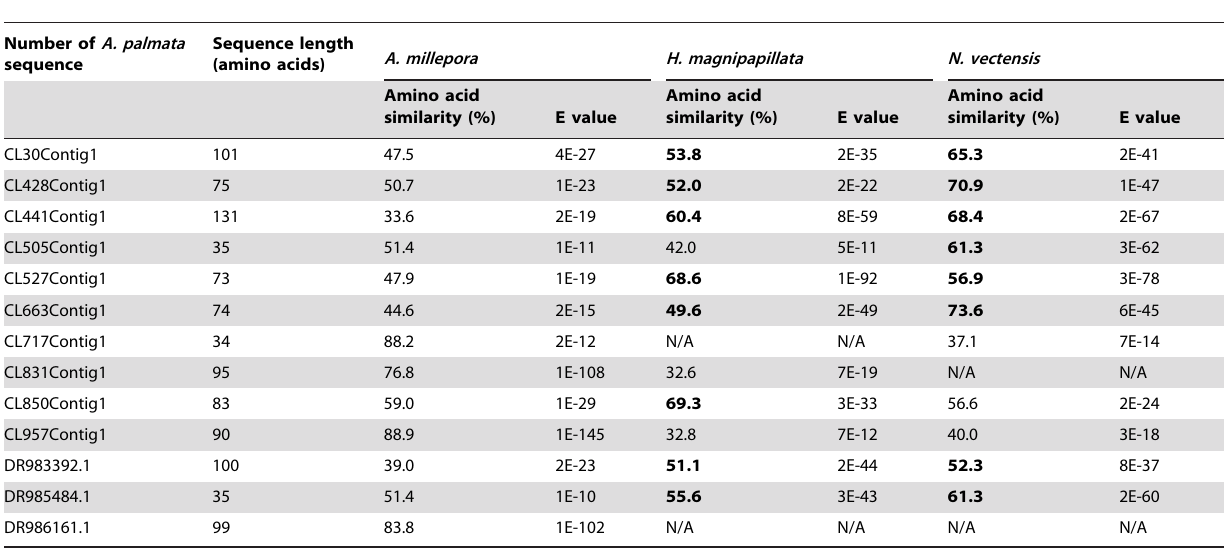
Table 1. Amino acid similarity and E value of ESTs between Acropora palmata and A. millepora , Hydra magnipapillata , Nematostella vectensis .